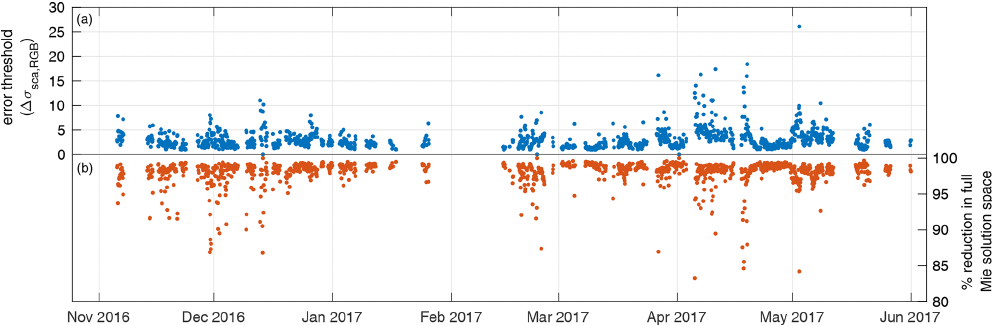
Figure 5. ( a , blue) Time series of the scattering error threshold ( (cid:49)σ sca , RGB , Mm − 1 ) and ( b , orange) percent reduction of the Mie lookup table solution space ( N = 157850) for UHSAS-NEPH retrievals during the background season of